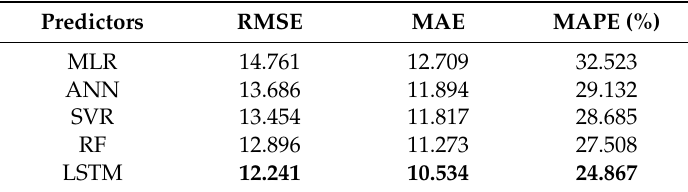
Table 2. Performance of prediction models using only non-spatial features. Legend: RMSE,